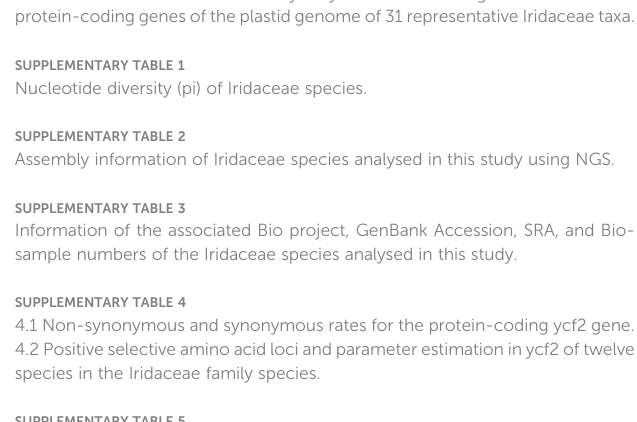
SUPPLEMENTARY TABLE 5 Number of codons and relative synonymous codon usage values in 31 representative plastid